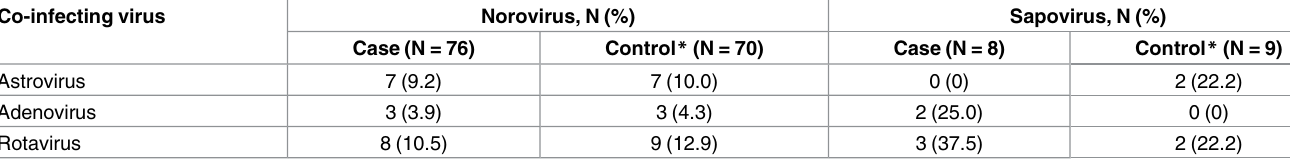
Table 1. Percent of enteric virus co-infections with norovirus or sapovirus.